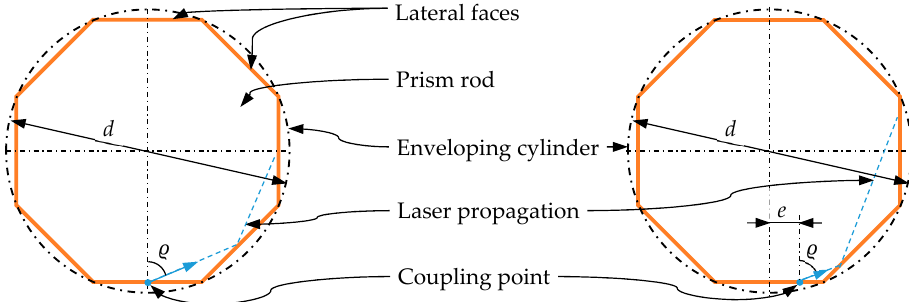
Figure 4. Left: coupling point of the laser at the first face of the prism rod (“central coupling”). Right: decentral coupling (this will be discussed in Section 3.1.3).